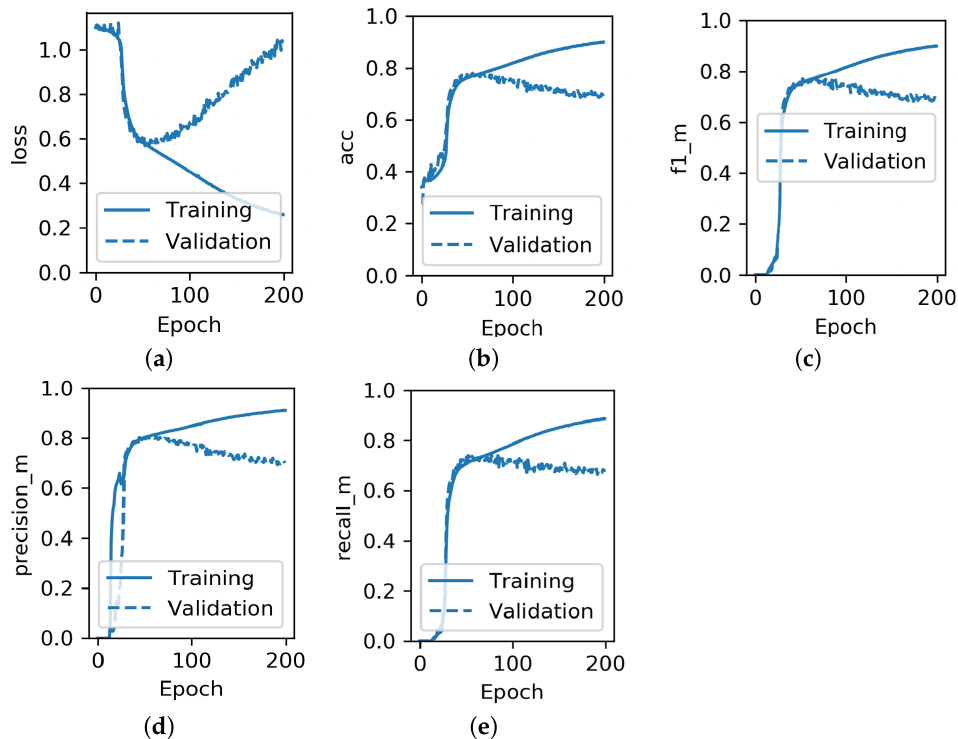
Figure 6. Development of performance metrics for the DeepLOB model during the training phase on training and validation dataset: ( a ) Categorical Cross-Entropy Loss; ( b ) Accuracy; ( c ) F1 score; ( d ) Precision; ( e )